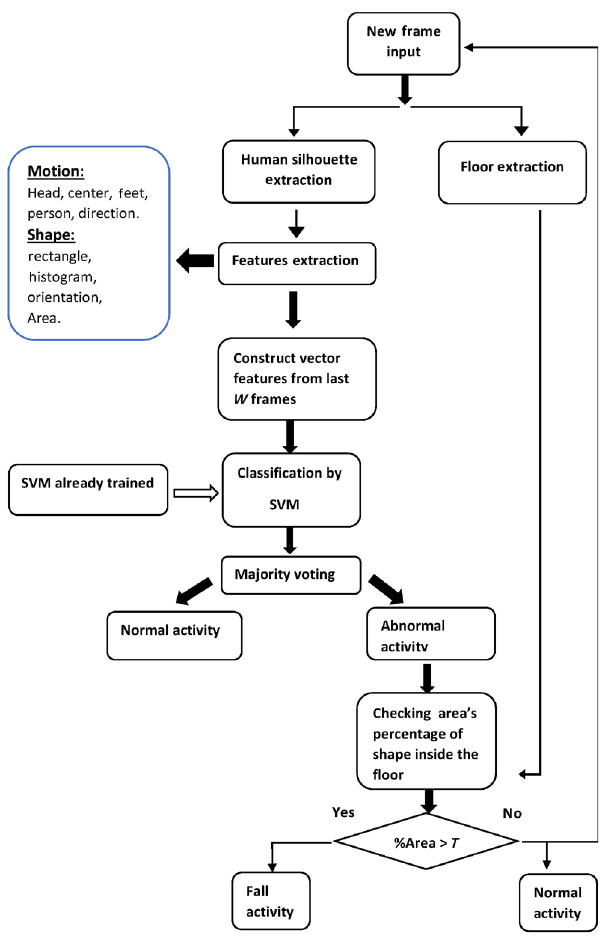
Fig. 1 Block diagram of our